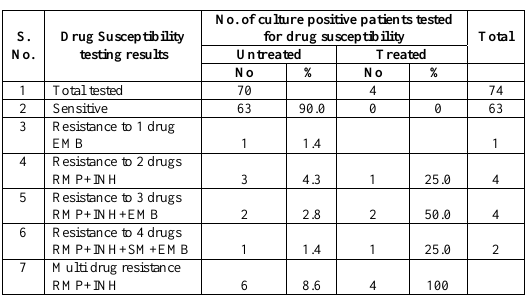
Table No. I Resistance pattern of all the isolates No. of culture positive patients tested for drug susceptibility TotalS. Untreated Treated